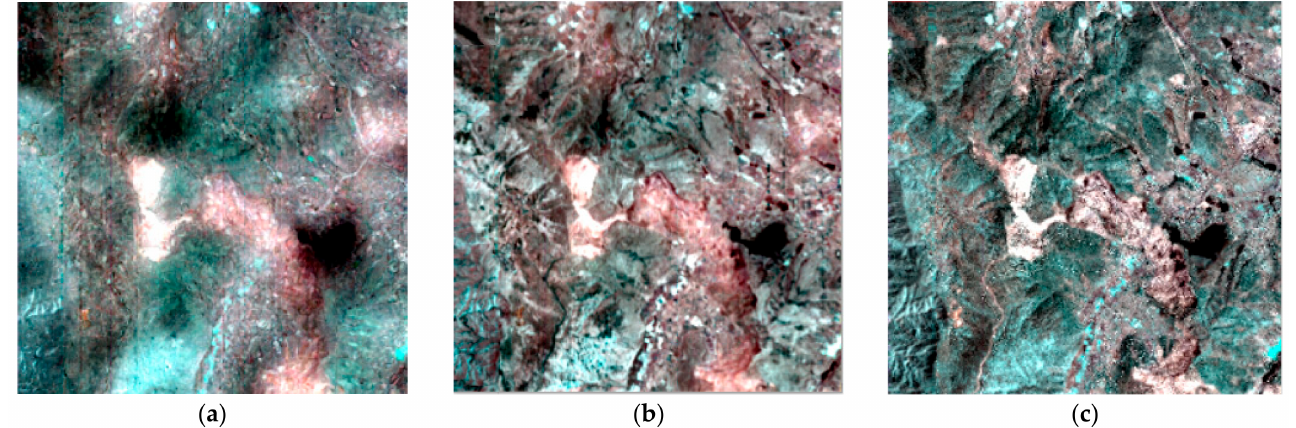
Figure 24. Different mode of up-sampling for the Dianchi dataset. ( a ) Nearest ( b ) bilinear ( c )